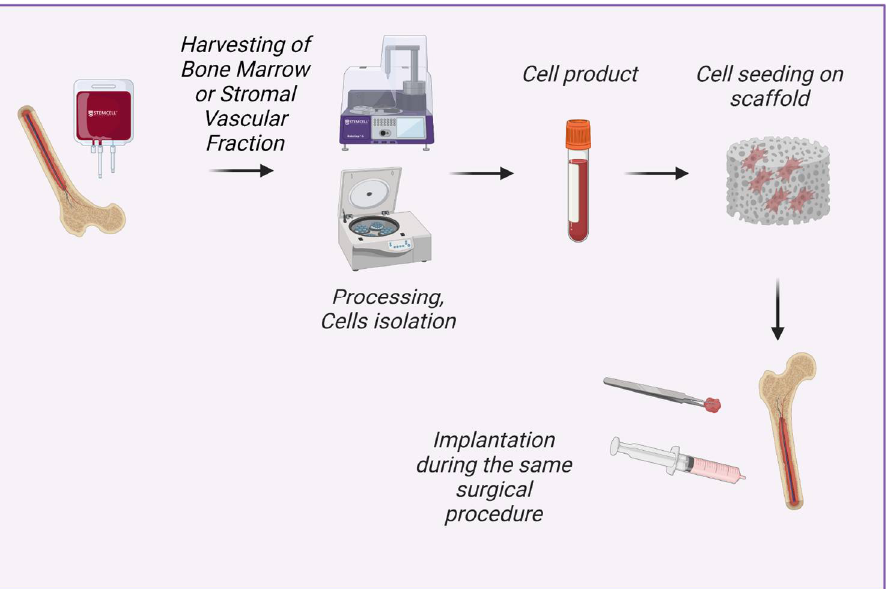
Figure 1. New concept of tissue engineering in situ: intraoperative isolation of cells with minimal manipulation, cell seeding on scaffold and implantation during the same surgical procedure. Created with